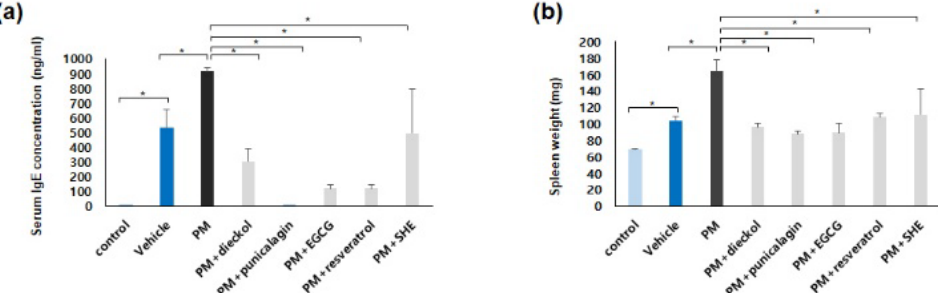
Figure 2. Preventative effects of antioxidants against the upregulation of the serum IgE levels and spleen weights in the particulate matter <10 μm (PM 10 )-treated, 2,4-dinitrochlorobenzene (DNCB)- induced atopic dermatitis mice. ( a ) The serum immunoglobulin E (IgE) levels were significantly decreased after the combined treatment with dieckol, punicalagin, epigallocatechin-3-gallate (EGCG), resveratrol, or Siegesbeckiae Herba extract (SHE) compared with those after PM 10 treatment only. The data in the bar graphs represent the mean ± standard deviation (SD) from three independent experiments (* p < 0.05). ( b ) The spleen weights were also significantly decreased after the combined treatment with dieckol, punicalagin, EGCG, resveratrol, or SHE compared with those after PM 10 treatment only. The data in the bar graphs represent the mean ± SD from three independent experiments (* p < 0.05).